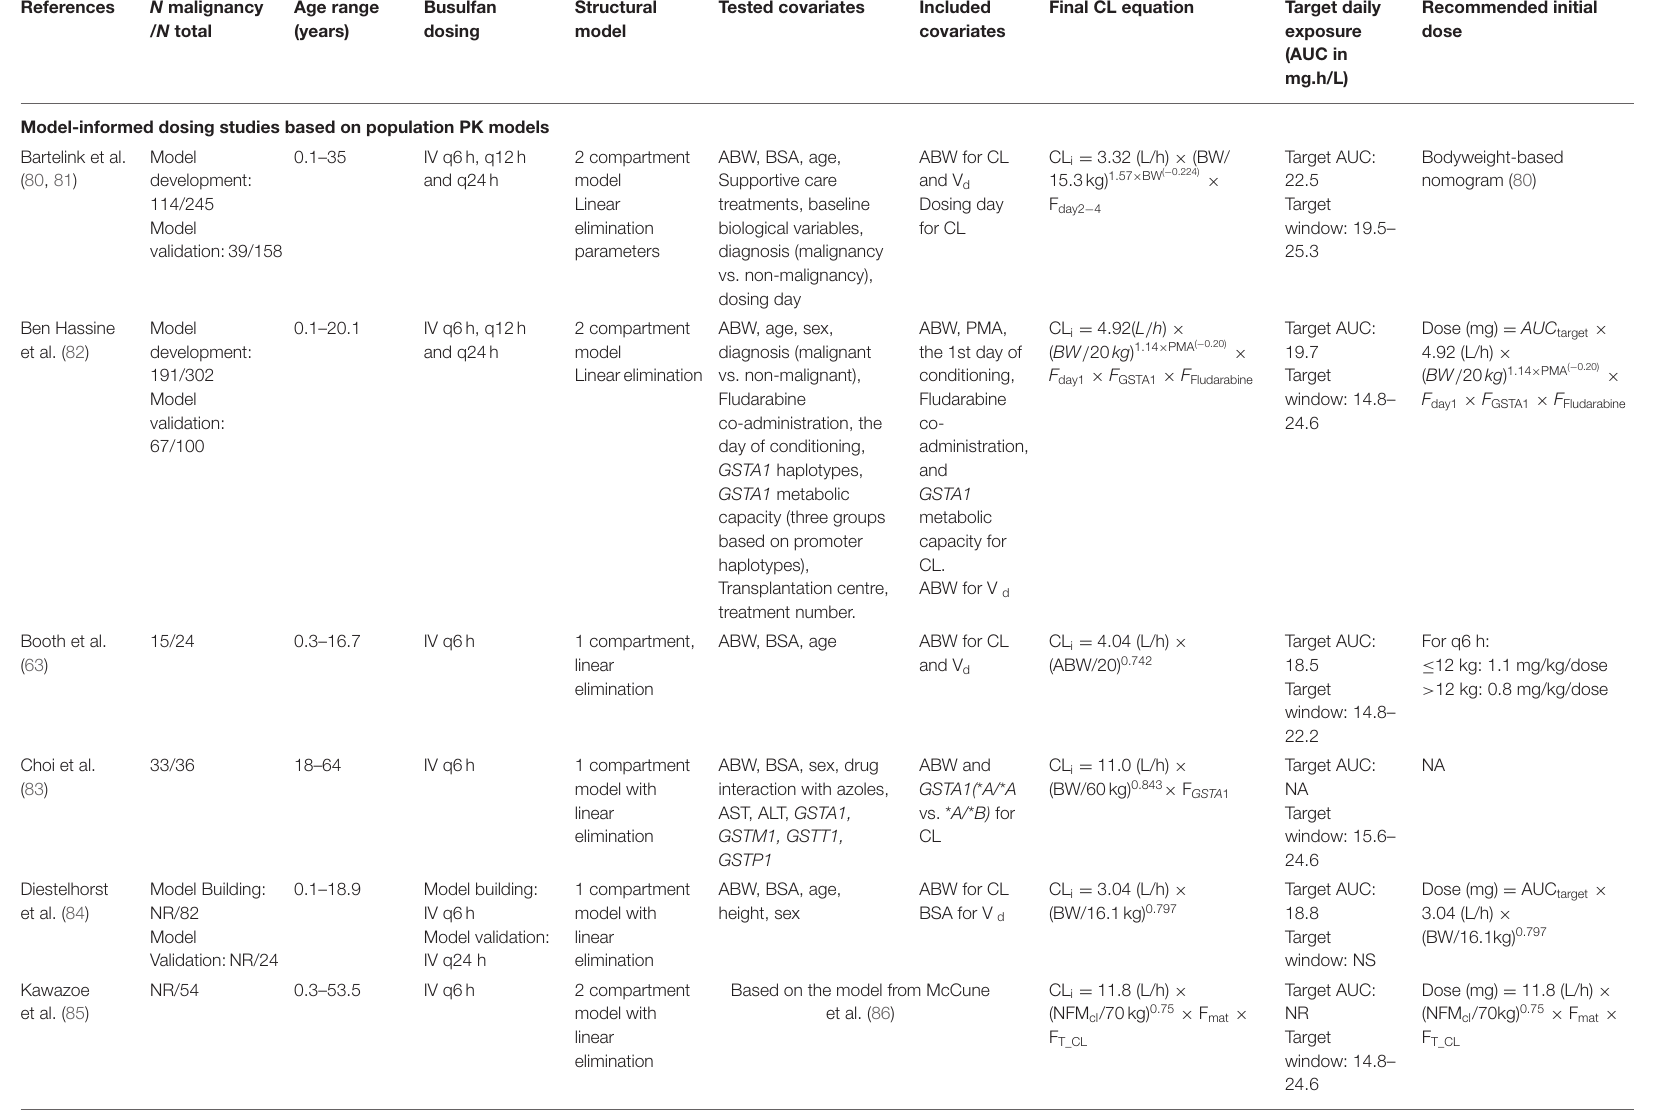
TABLE 2 | Summary of population PK models of